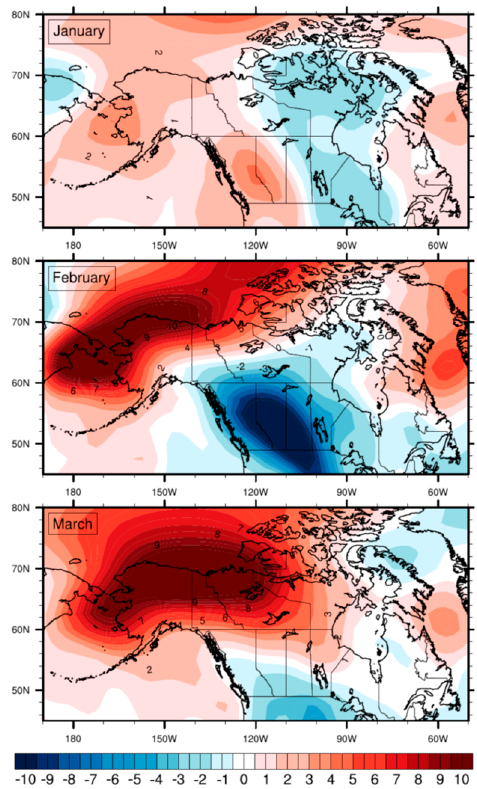
Figure 3. Monthly surface air temperature anomalies (°C) for January–March 2019.